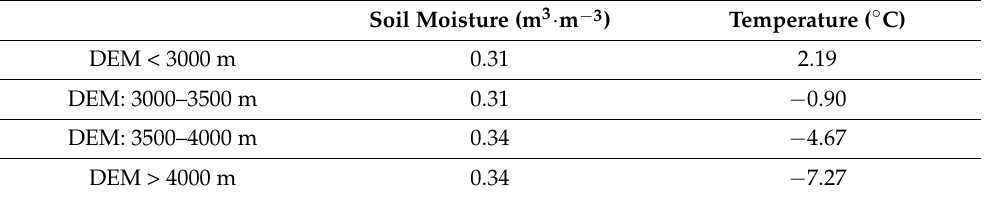
Table 2. The annual average soil moisture and temperature from 2001 to 2020 in four elevation